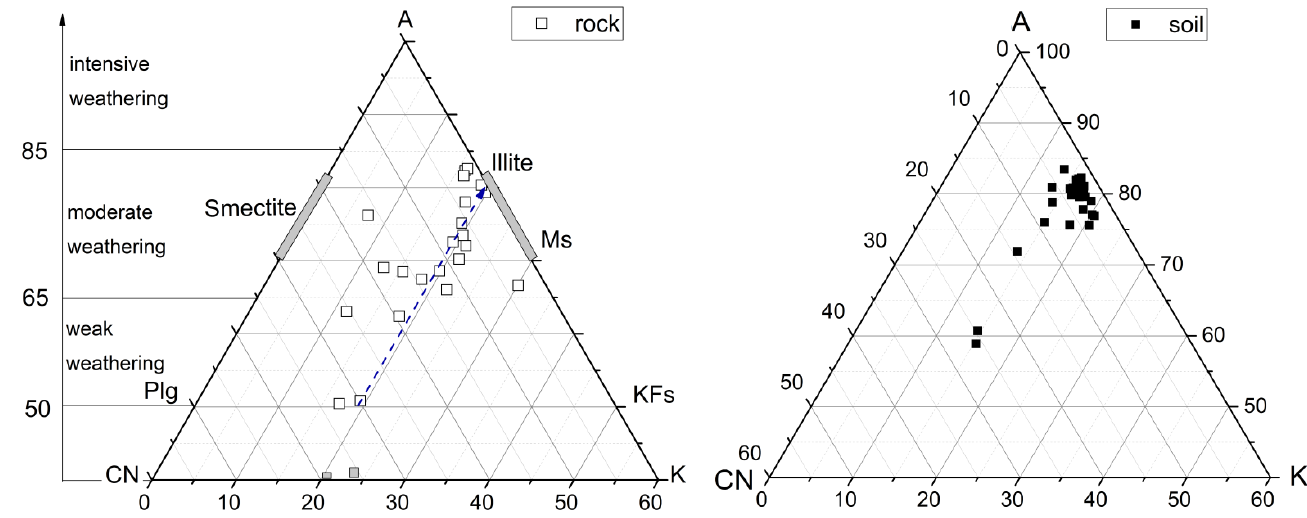
Figure 5. The A-CN-K ternary system [15] (Ms-mucovie, Plg-plagioclase, KFs-potassium feldspar; dashed line–rhyolite weathering trend). dashed line–rhyolite weathering